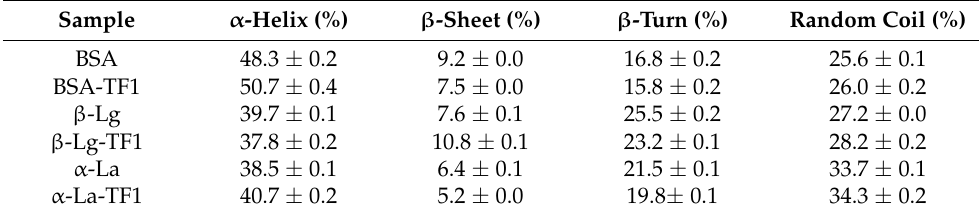
Figure 5. Circular dichroism (CD) spectra of free BSA ( a ), β -Lg ( b ) and α -La ( c ) and in the presence of TF1 (15 µM) at 298 K and pH 7.4. Table 2. CD spectra parameters of BSA/ β -Lg/ α -La in the absence and presence of TF1.